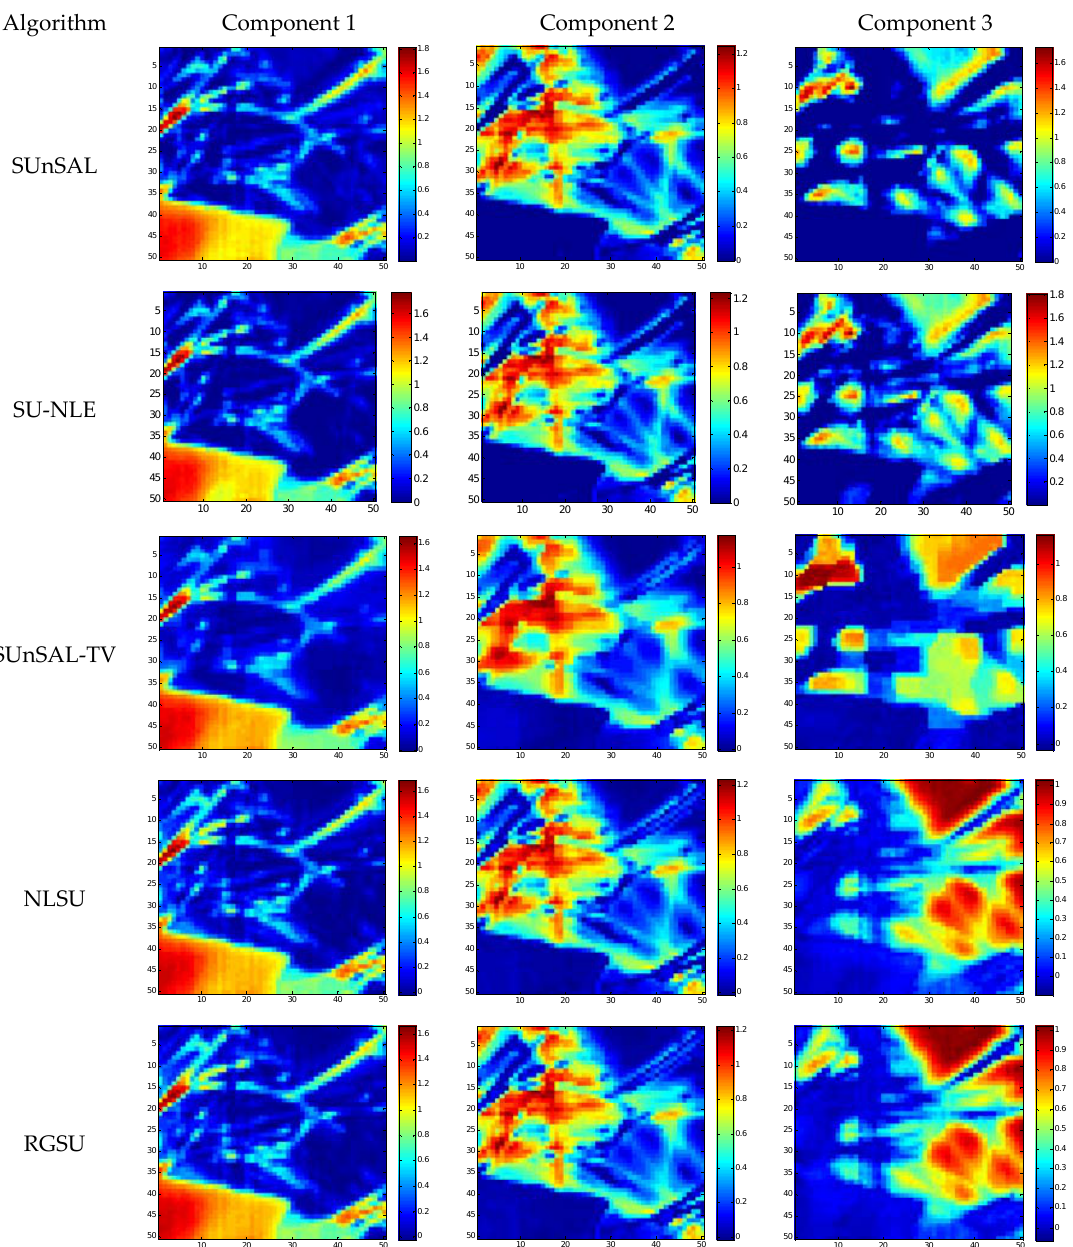
Figure 10. Estimated abundances of different components for the Nuance data.